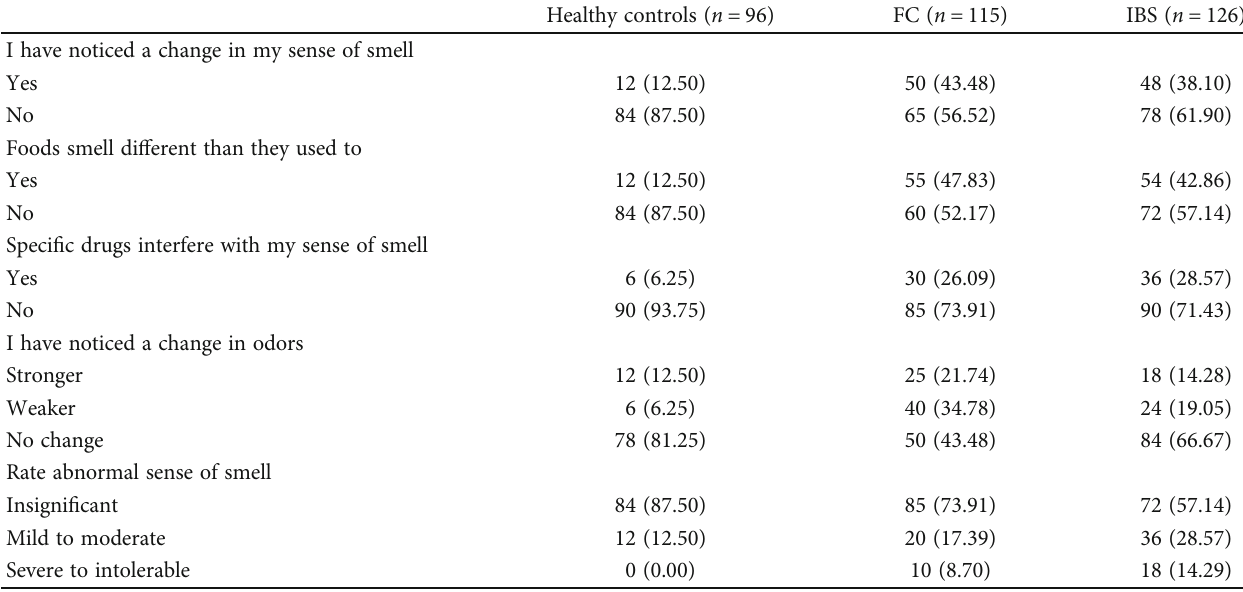
Table 5: Breakdown of the detailed smell complaints from the taste and smell survey.